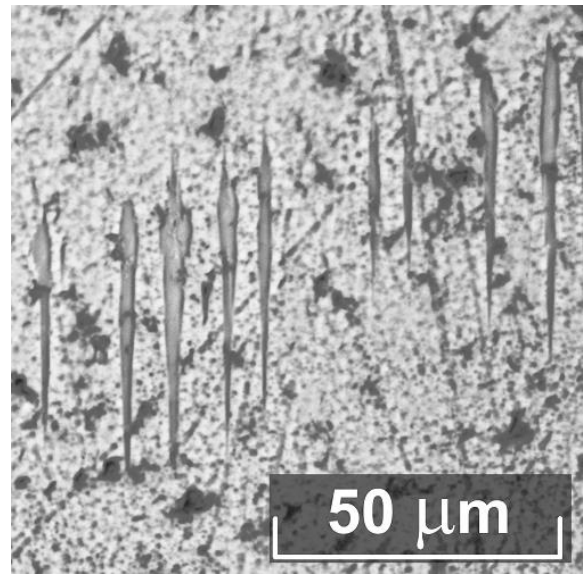
Figure 4. Wedge-shaped nanoscale ( ≈ 100 nm) domains, in the region of the periodic domain structure in the Z-plane of the LiNbO 3 :Er (2.77 wt.%) crystal. Image obtained using the atomic force microscope SMM-2000.